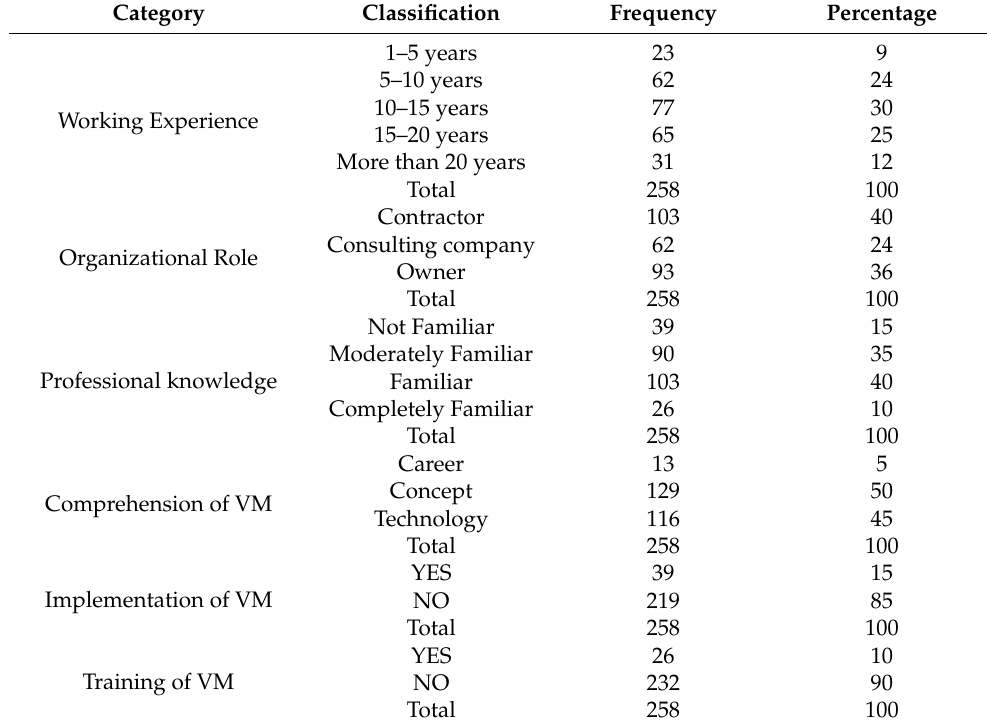
Table 2. General information of the respondents in this